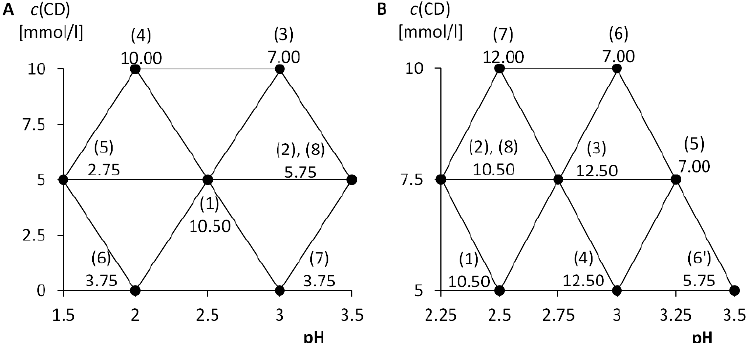
Figure6. Simplexproceduresinoptimizationofseparationconditions; ( A )full-simplex; ( B )half-simplex; Figure 6. Simplex procedures in optimization of separation conditions; ( A ) full-simplex; ( B ) half- simplex; fused-silica capillary: od/id = 375/75 μ m, total/effective length: 58.5/50.0 cm; BGE: 50 fused-silica capillary: od / id = 375 / 75 µ m, total / e ff ective length: 58.5 / 50.0 cm; BGE: 50 mmol · L − 1 mmol·L − 1 phosphate buffer (46.6 mmol·L − 1 HCl at pH 1.5), variable CM- β -CD concentration, variable phosphate bu ff er (46.6 mmol · L − 1 HCl at pH 1.5), variable CM- β -CD concentration, variable pH; voltage: pH; voltage: 20 kV (10 kV for pH 1.5); temperature: 25 °C. 20 kV (10 kV for pH 1.5); temperature: 25 ◦